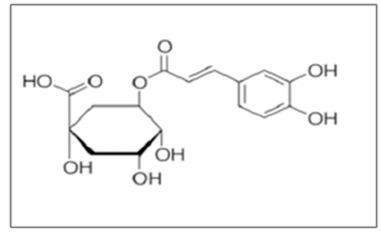
Figure 9. Chemical structure of chlorogenic acid.